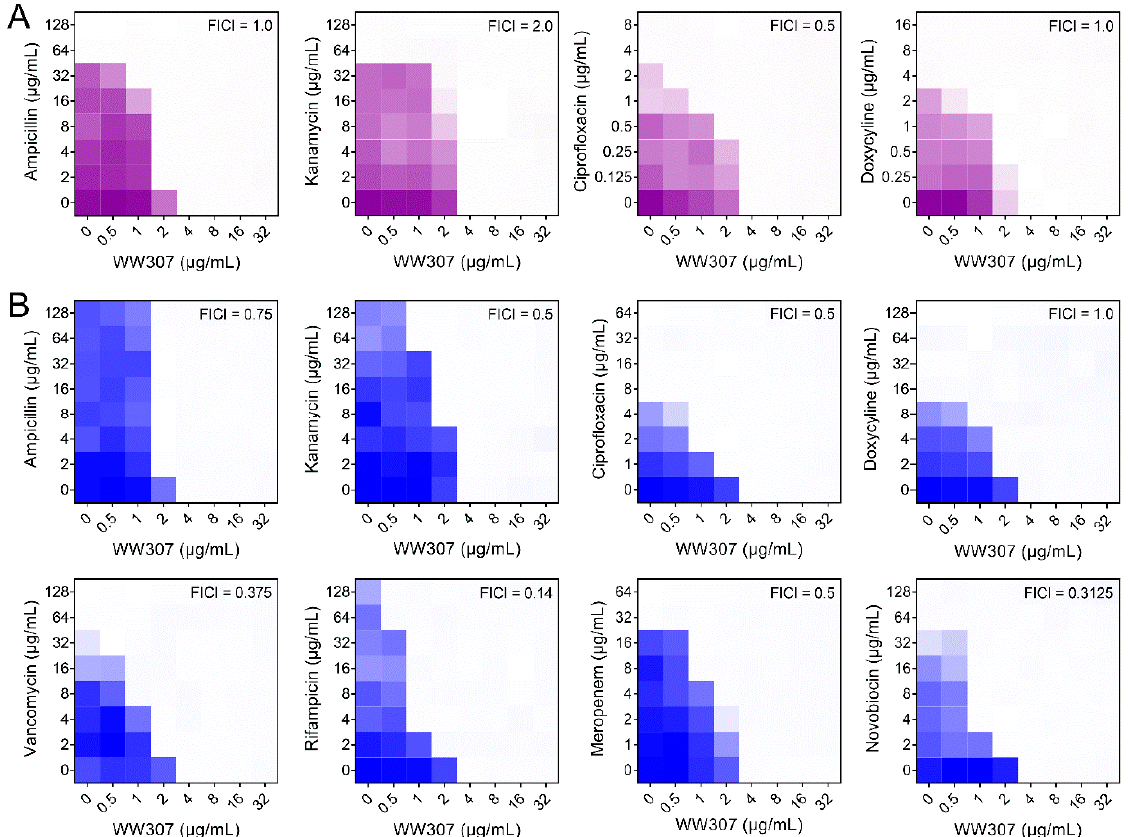
Figure 3. Checkerboard broth microdilution assays between WW307 with different classes of antibiotics against methicillin-resistant Staphylococcus (MRSA) T144 and E. coli B2. ( A ) Synergistic antibacterial activity of WW307 with four antibiotics against MRSA T144. ( B ) Synergistic antibacterial activity of WW307 with eight antibiotics against E. coli B2. Bacterial cells and drugs were cultured at 37 ◦ C for 16–18 h, then the density of cells at 600 nm was measured, the darker color means the higher density of bacteria. Data represent the mean of two biological